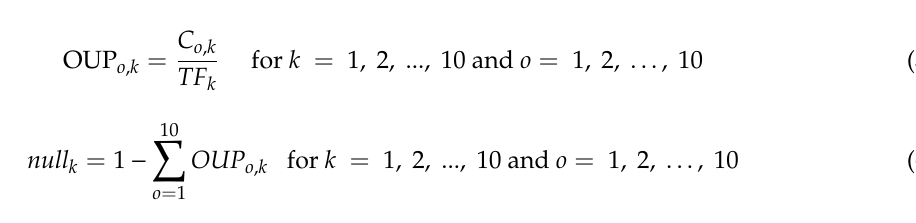
Table 4. Sample data for object usage counts ( C ) for ten actions in the CAD-120 dataset. Medicine Box